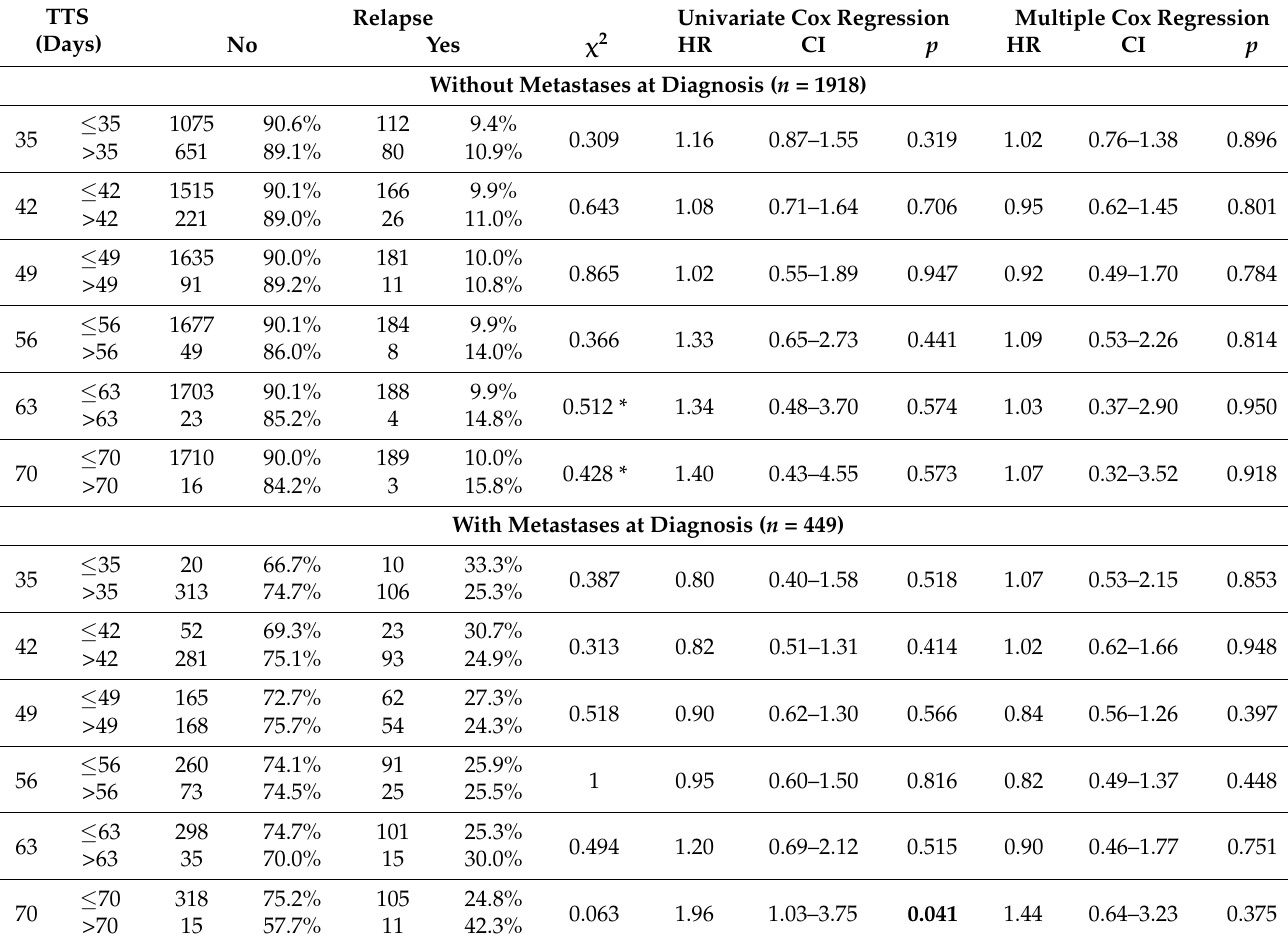
Table 1. Results of univariate und multivariate regression analysis of the impact of TTS on RFS at different time points for patients with unilateral WT with and without metastases at